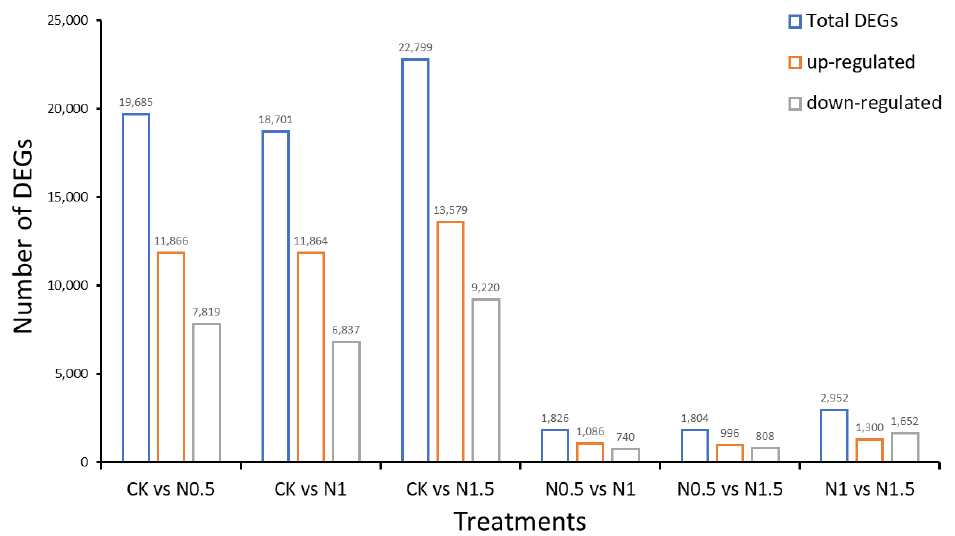
Figure 3. Summary of differentially expressed genes (DEGs) up-regulated and down-regulated in the control and 3% NaCl treated seedling samples comparison groups; X-axis depicts all possible comparisons for NaCl treatments in differential expression patterns. Y-axis displays the number of DEGs as blue bars showing total DEGs; orange reveals up-regulated and gray depicts down-regulated DEGs. CK: no treatment; N0.5: NaCl treatment for 0.5 h, N1: NaCl treatment for 1 h, and N1.5: NaCl treatment for 1.5 h. Further exploration of transcriptional changes among the treated cotton seedling sample groups illustrated co-expression of 13,364 DEGs between the CK-vs.-N0.5, CK-vs.- N1, and CK-vs.-N1.5 comparisons, and 63 DEGs between the N0.5-vs.-N1, N0.5-vs.-N1.5, and N1-vs.-N1.5 comparisons. The maximum number of DEGs, i.e., 3281, was commonly expressed in the comparison group CK-vs.-N0.5 and CK-vs.-1.5 regarding salinity toler- ance (Figure 4).